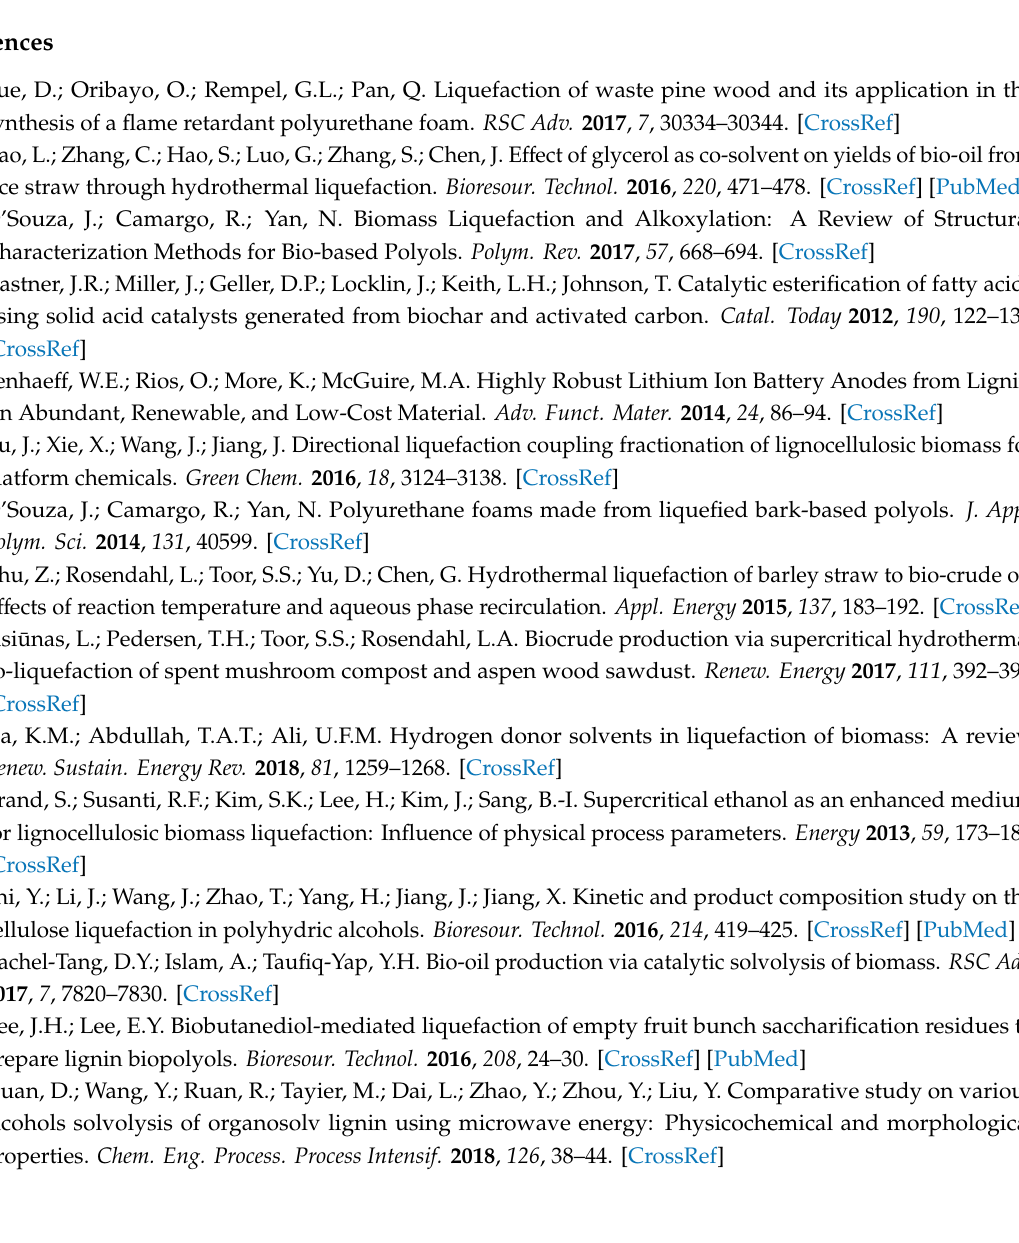
Table S1: GC-MS analysis results of liquefied products from optimum